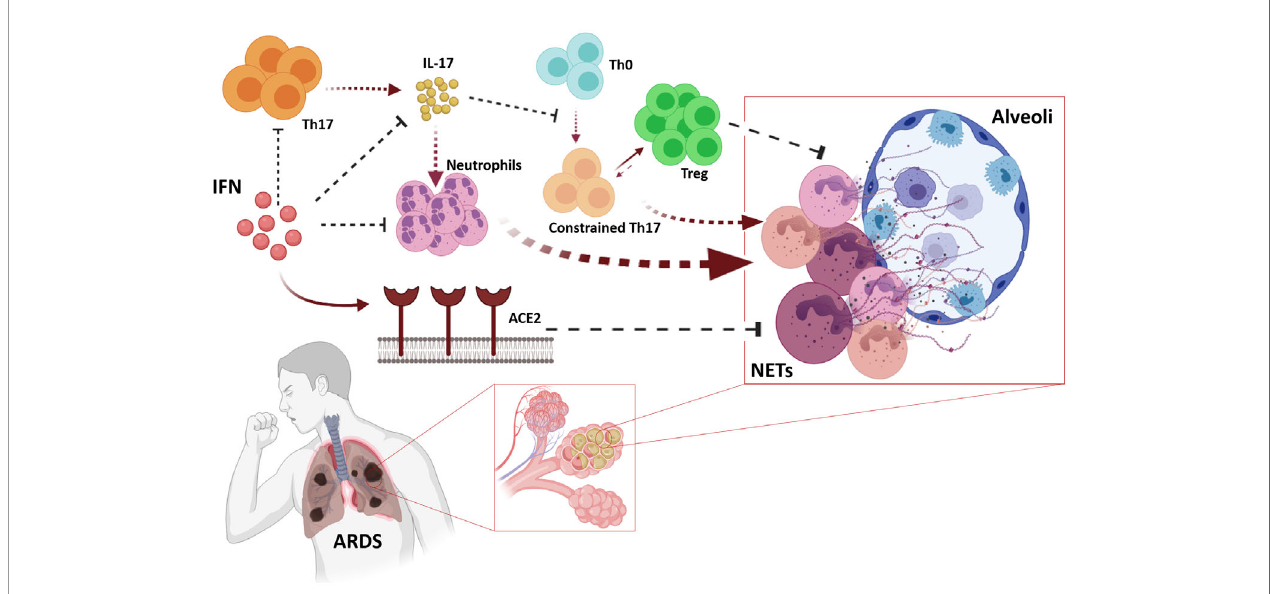
FIGURE 5 | Pleiotropic effects of IFNs may cope with Acute Respiratory Distress Syndrome (ARDS). IFNs impair biological responsiveness of neutrophils, and suppress IL-17 expression which also avoids maladaptive neutrophil recruitment affecting neutrophil-mediated in fl ammation regulated by T cells expressing IL-17. The relative scarcity of IL-17 avoids clonal expansion of Th17 cells, which allows Treg to perform its counterbalancing role on immune homeostasis. IFN-induced ACE2 contributes avoiding the pathogenic effects of neutrophils in lung